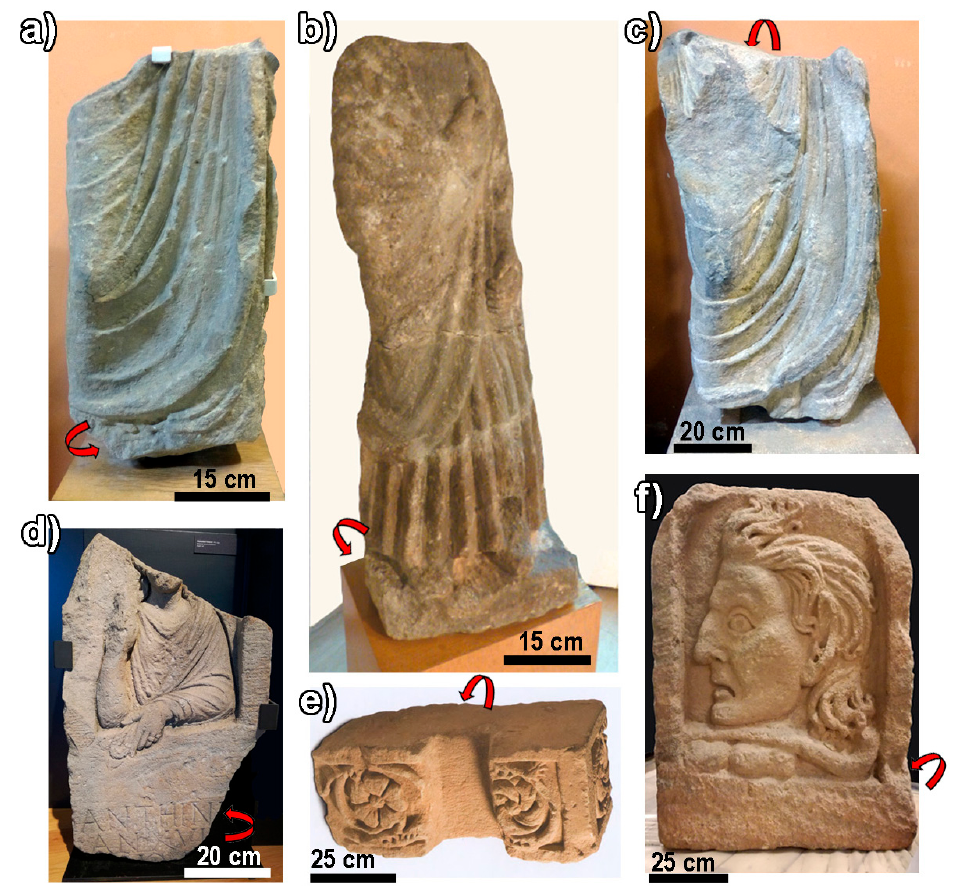
Figure 6. The sampled archaeological pieces. ( a ) Togatus sculpture MAC-19008 found in the south-western sector of the city walls of Barcino. ( b ) Sculpture of a woman wearing a toga, MAC-19018, found in the south-eastern sector of the city walls of Barcino. ( c ) Togatus sculpture MAC-19075 found together with MAC-19008. ( d ) Stele on display at MdC, found between Zona Franca and Bellvitge districts (Barcelona). ( e ) Frieze MdT-25992 decorated with acanthus scrolls motives, found in the Seu d’Ègara precinct (Terrassa). ( f ) Acroterion MdT-26000 featuring a satyr head, found together with MdT-25992. Red arrow indicates the location of the retrieved samples.